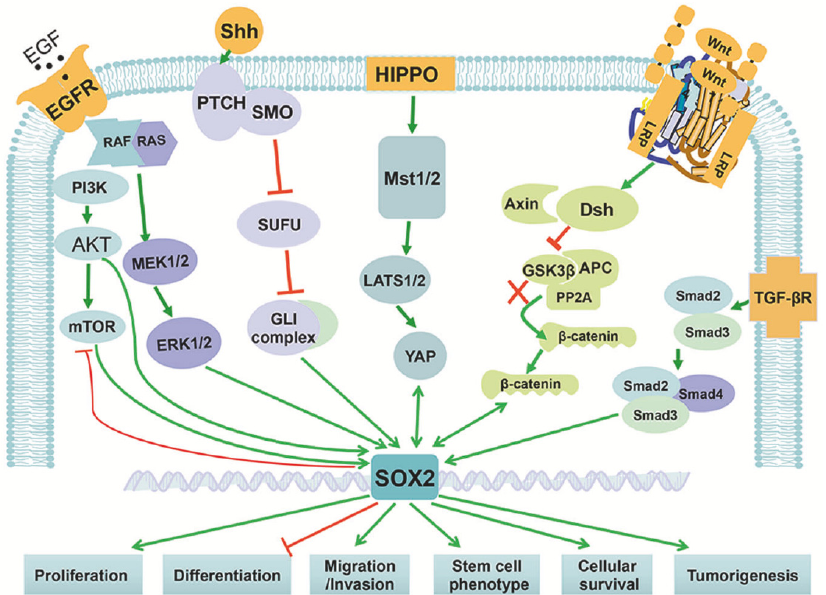
Figure 5. SOX2 cross-talks with various cellular pathways. SOX2 cross-talks with some signaling pathways including TGF- β , WNT, HIPPO, Hedgehog, and EGFR regulates cell proliferation, survival, migration, and differentiation. Reprinted by permission from Springer Nature, Signal Transduction and Targeted Therapy [76], Copyright 2020.